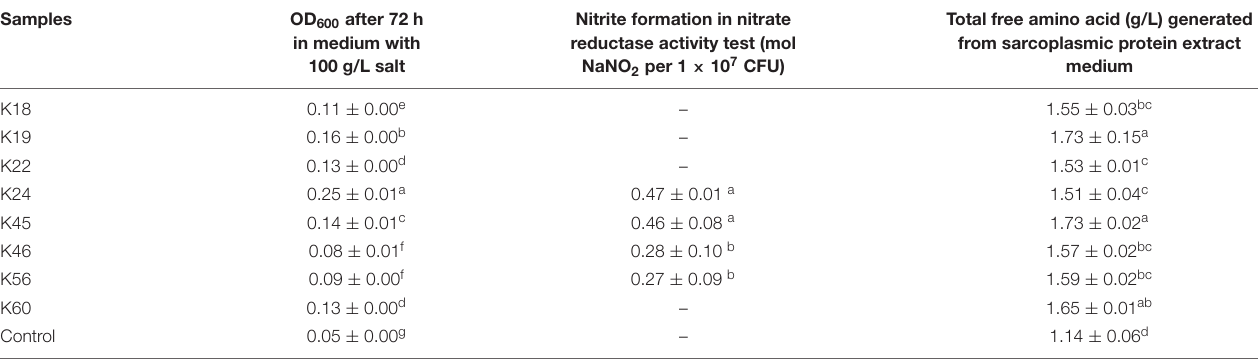
TABLE 2 | Test results of eight Kocuria rhizophila isolates for salt tolerance, nitrate reductase activity, and proteolytic activity.